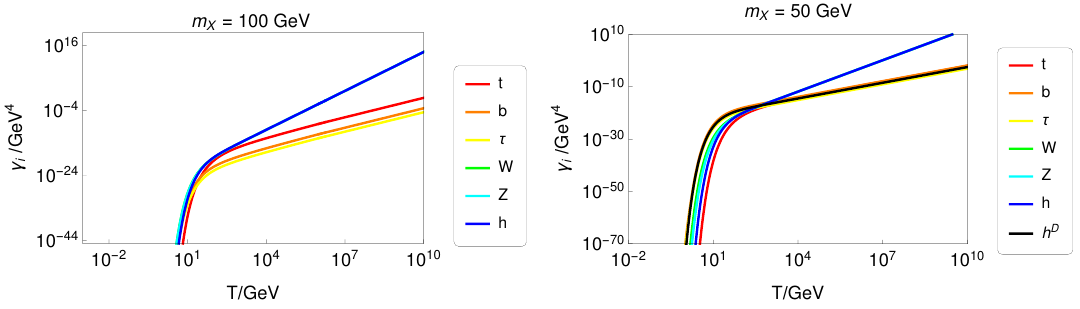
Figure 1 . Evolution of the reaction densities for various SM channels as functions of the SM sector temperature T for m X = 100 GeV and (cid:20) = 2 : 09 10 (cid:0) 12 (right panel). The chosen values of (cid:20) result in the observed DM relic abundance. (cid:20) = 2 : 40 (cid:2)